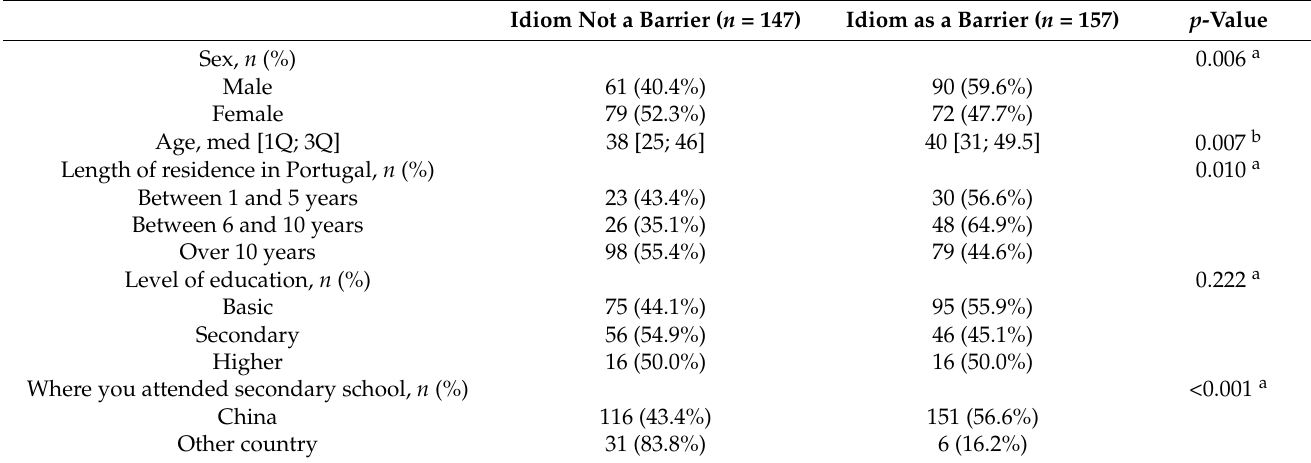
Table 3. Comparison of the variables sex, age, length of residence in Portugal, level of education and where you attended secondary school according to the indication of language as a barrier to accessing healthcare in Portugal ( n = 304).